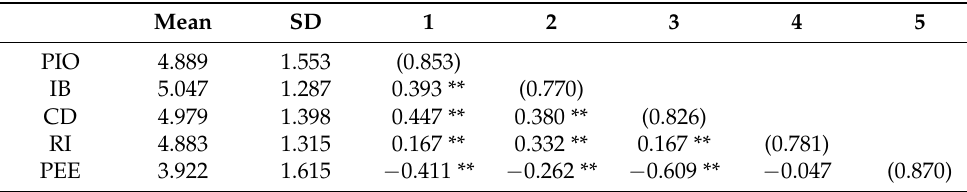
Table 4. The matrix of descriptive statistics and